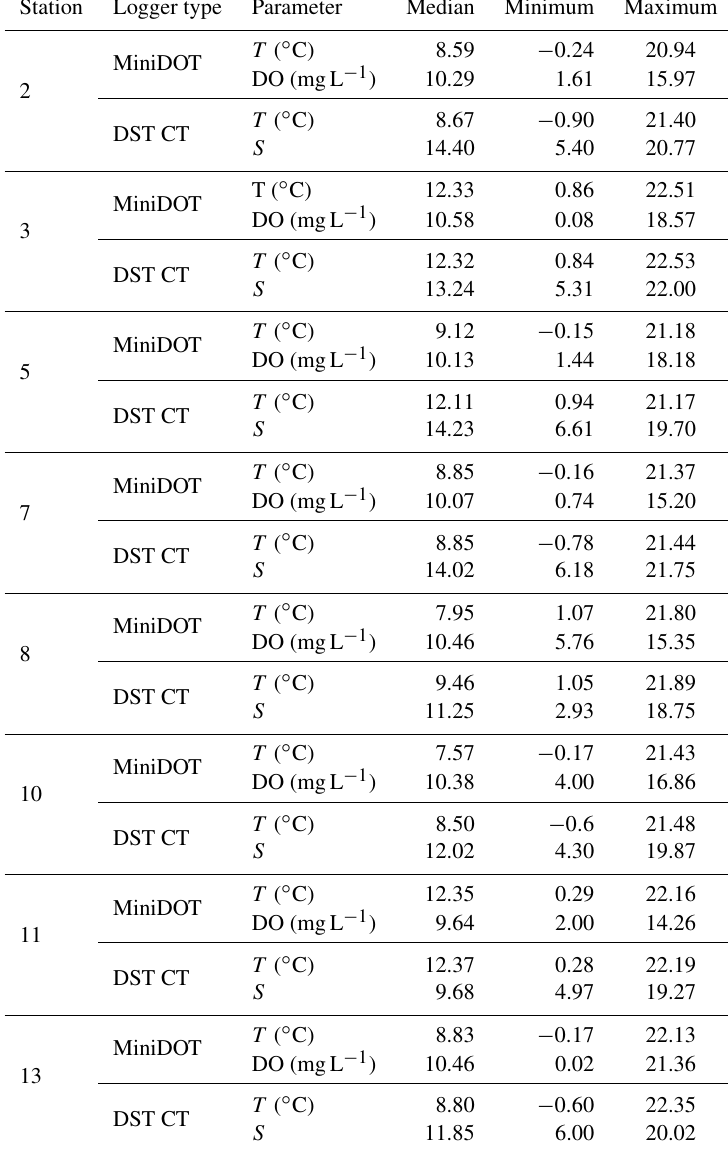
Table 6. Median and range of recorded measurements obtained by self-contained data loggers over the respective monitoring period. Tem- perature ( T ), dissolved oxygen concentration (DO) and salinity ( S ) were measured by two types of data loggers. Note that data can cover different time periods (see Sect. 3.2) and that only data with a quality flag of 1 were